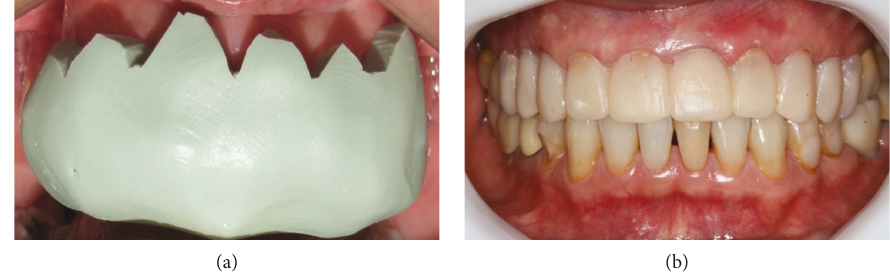
Figure 6: (a) Silicone mold fi lled with bis-acryl resin. (b) Temporaries in position.